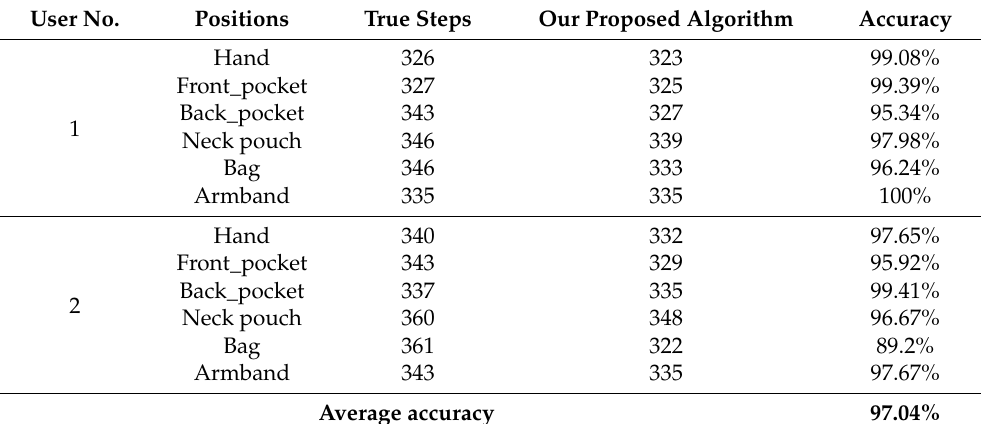
Table 7. Performance with Public